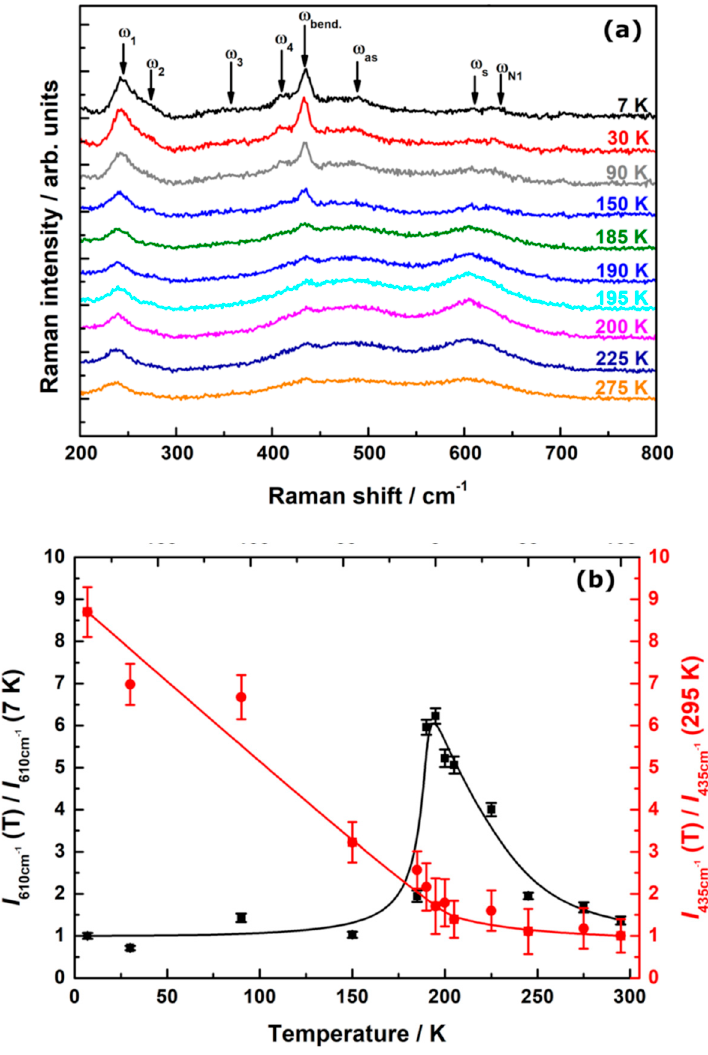
Figure 5. ( a ) Raman spectra of an LPMCMO / MgO(100) film (y = 0.4) measured in the temperature range 7to 300 K; and ( b ) Normalized intensity of the JT phonon band ( ω s ) I 610 cm − 1 and of the bending mode ( ω bend ) as a function of temperature. “Reprinted figure from [31]. Licensed under the Creative